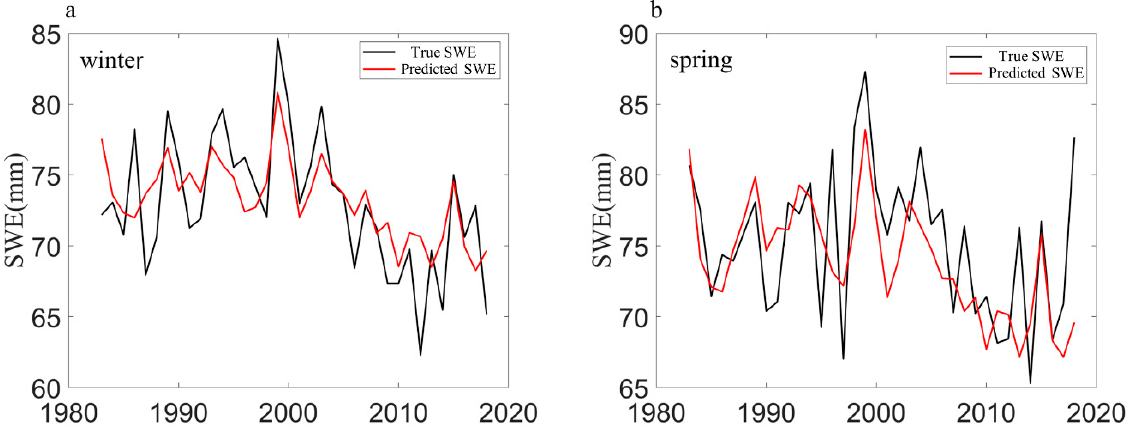
Figure 12. ( a , b ) Comparison of the forecast results and actual values of the Eurasian winter–spring SWE from 1983 to 2018. The result from 1983 to 1999 is the training data and 2000–2018 is the forecast.